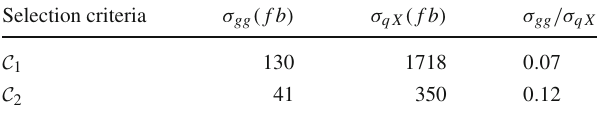
Table 1 Comparison of cross-sections in the gg and the q ¯ q channels after application of various selection criteria. Criterion C 1 denotes the kinematic selection cuts [Eq. (4)], C 2 stands for selection of events that pass through C 1 and have a gluon jet as the leading ( p T )